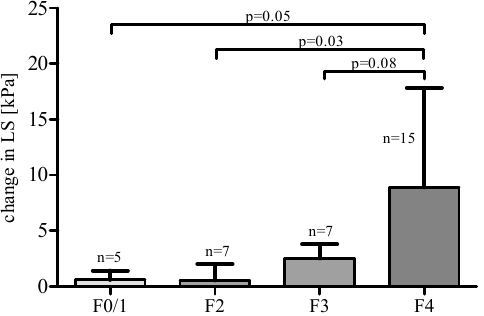
Figure 2. Median values of sequential LS measurement according to baseline fibrosis stage. EOT—end of treatment; FU24—follow-up visit at week 24 after treatment; FU96—follow-up visit at week 96 after treatment; F0/1—F4: METAVIR scores; LS—liver stiffness; kPa—kilopascal; the upper and bottom side of each box represent 25th and 75th percentile (interquartile range); the line passing through the field indicates the median; whiskers indicate minimum and maximum. Statistical method: analysis of variance ANOVA.